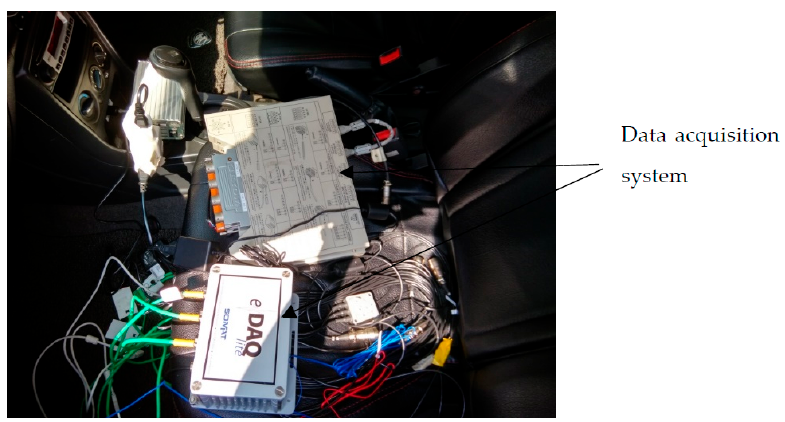
Figure 4. Strain gauge setup on spring.